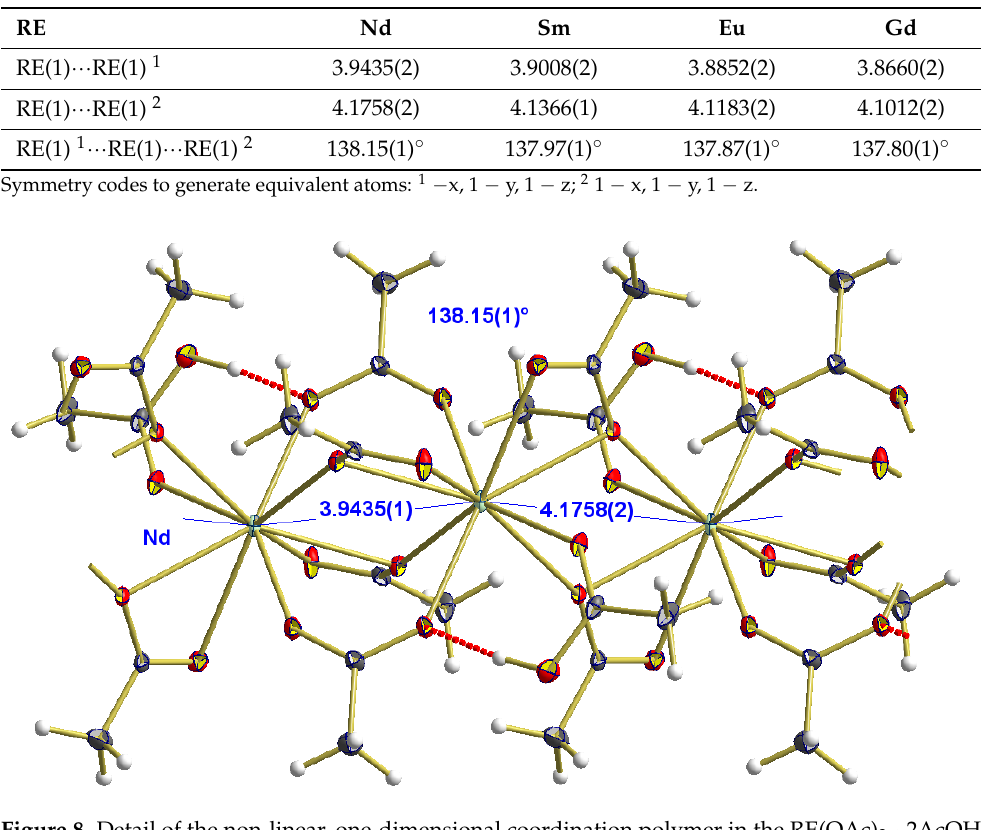
Figure 8. Detail of the non-linear, one-dimensional coordination polymer in the RE(OAc) 3 · 2AcOH structure type with RE ··· RE distances [Å] and angles; example RE = Nd. Table 6. Interatomic RE···RE distances [Å ] and angles in the RE(OAc) 3 · 2AcOH structure type.